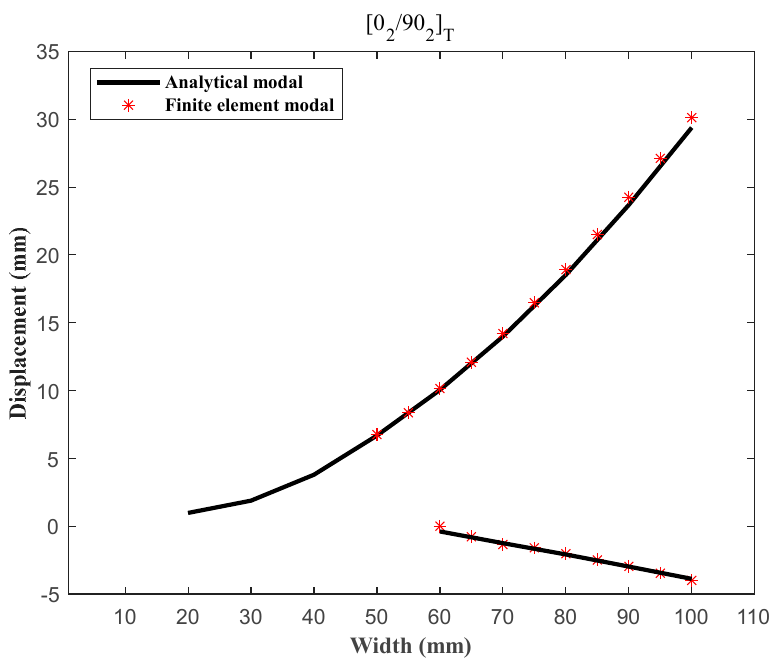
Figure 7. Bifurcation diagram of laminated plates with [0 2 /90 2 ] T plies of different sizes. The solid line represents the FEA simulation results and the red discrete points denote the prediction results of the analytical model. It can be seen that under ideal conditions the corner displacements of rectangular laminates [0/90] T and [0 2 /90 2 ] T bifurcate with the increase of the side lengths of the laminates. Compared with the FEA results, the two methods were similarly successful in predicting the vertex displacement of the